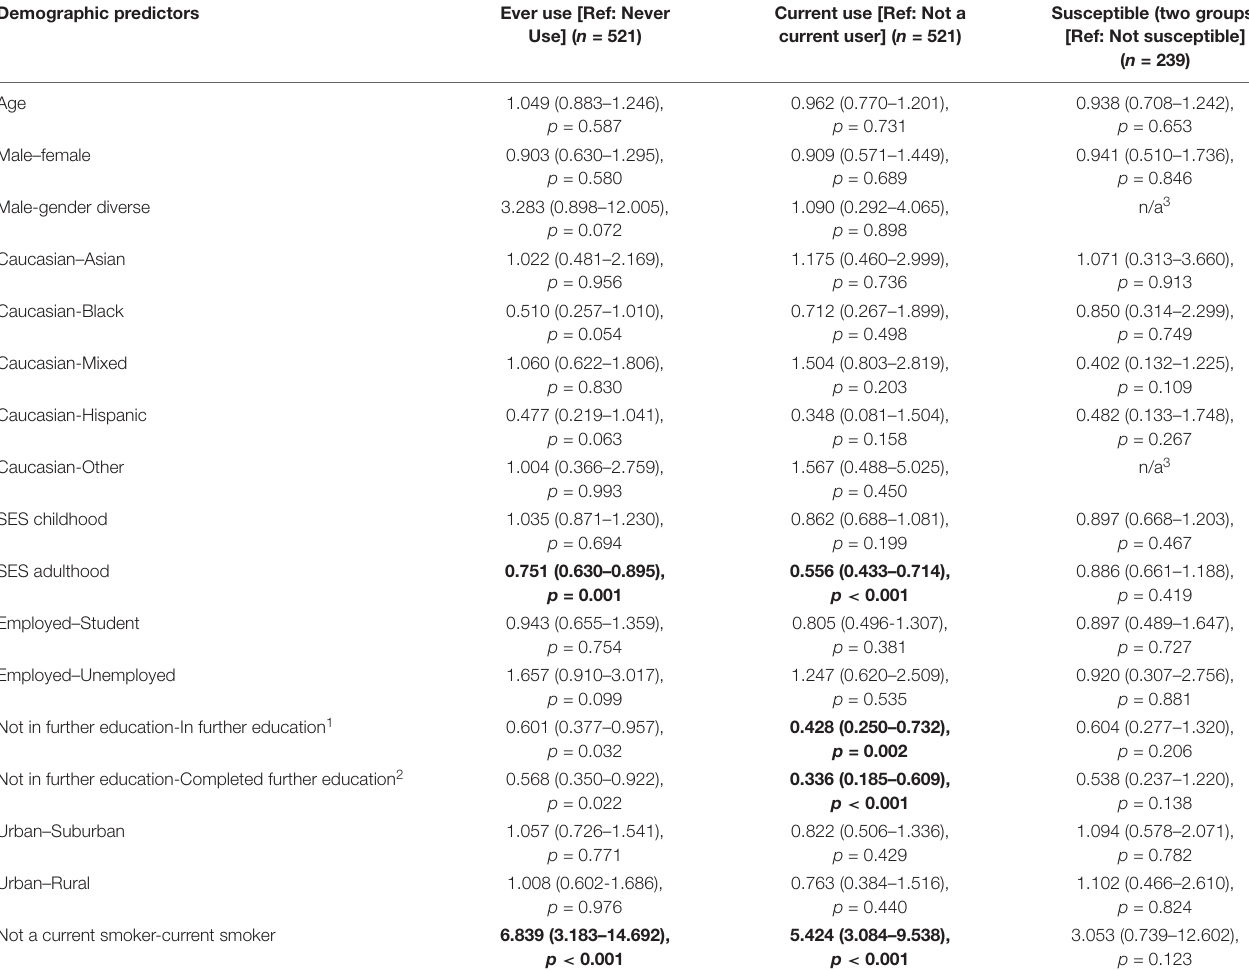
TABLE 2 | Results of independent logistic regressions showing estimates in odds ratios (confidence intervals) for demographic predictors of ENDS ever-use, current use, and susceptibility based on the two groups categorization. Demographic predictors Ever use [Ref: Never Use] ( n =